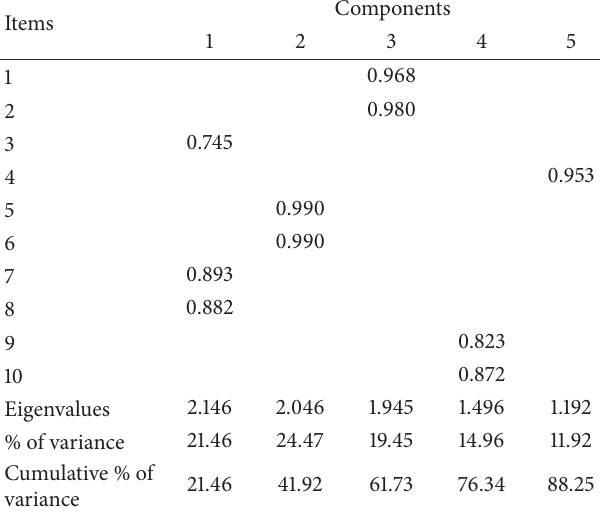
Table 3: Results of exploratory factor analysis of the Moroccan Summary of Diabetes Self-Care Activities items (10-item version): factors loadings and explained variance.